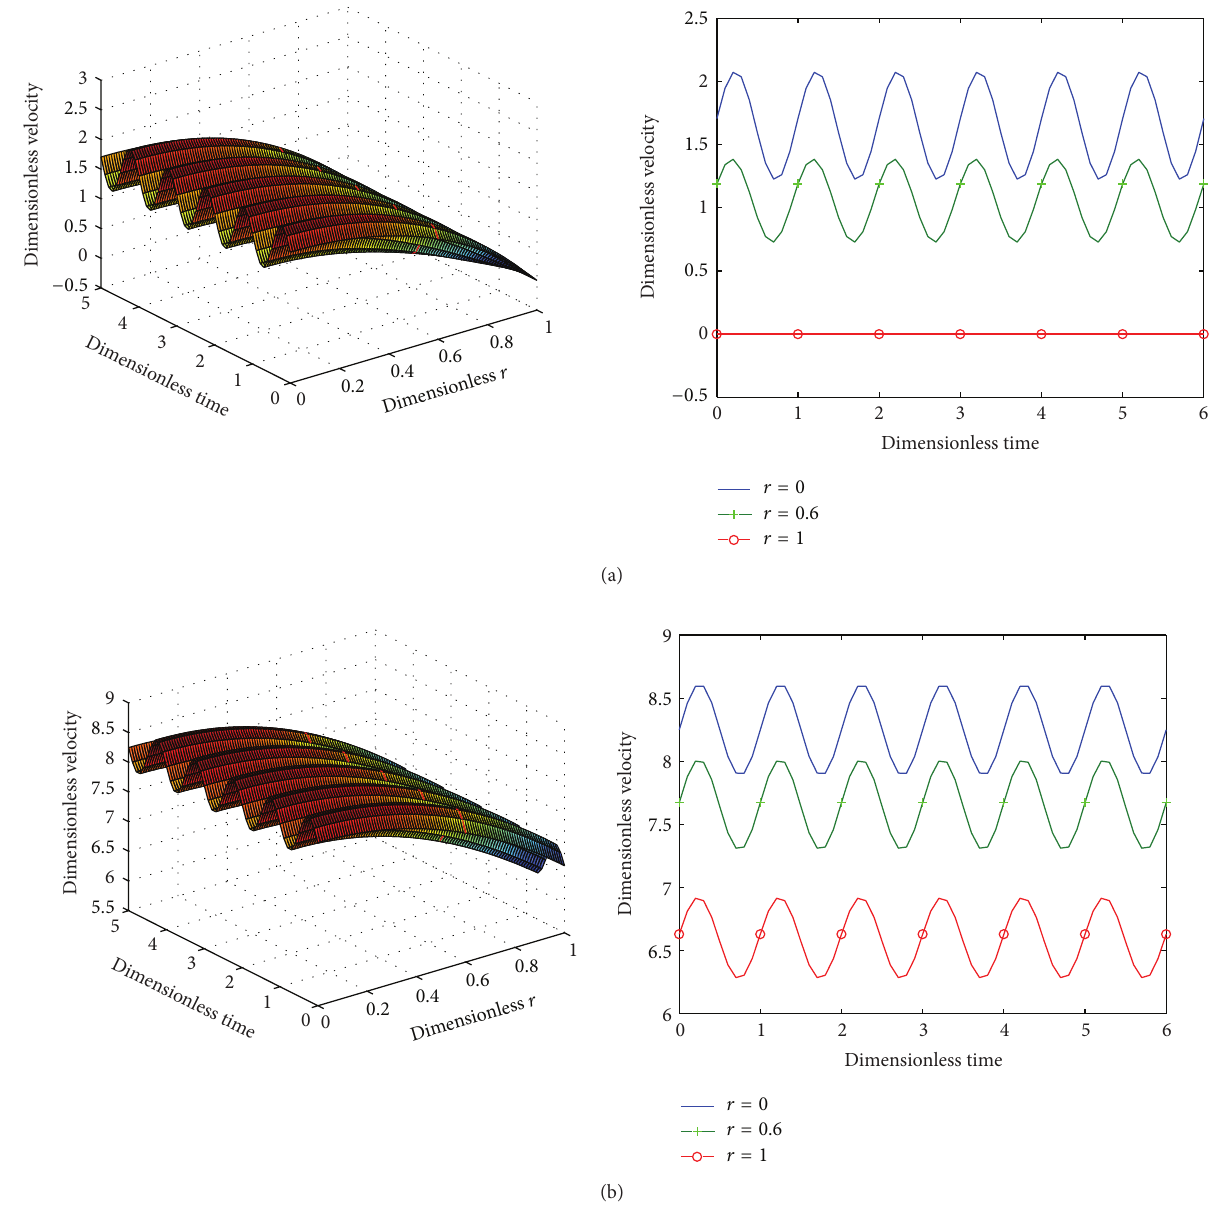
Figure 1: The velocity profile in the small artery with radius 0.15cm under two different slip parameter values: (a) 𝑙 𝑏 = 0 ; (b) 𝑙 𝑏 = 2 . In the figure, the 3D graphs show the variation of velocity as a function of time and location, while the 2D graphs show the variation of velocity with time at three radial locations including the artery centre ( 𝑟 = 0 ), the interface of inner-outer layer ( 𝑟 = 0.6 ), and the arterial wall ( 𝑟 = 1